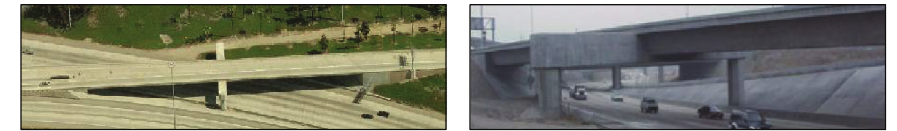
Figure 3: Two views of the benchmark highway bridge.